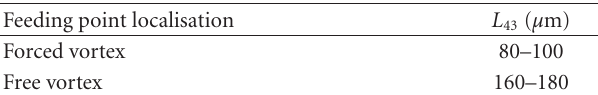
Table 2: Mean volume crystal size depending on the feeding